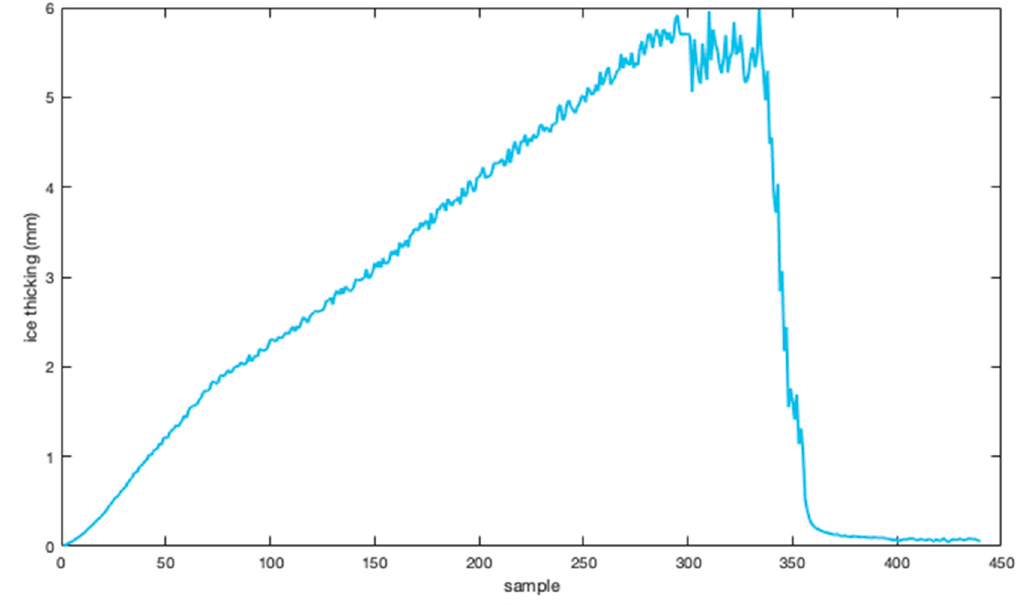
Figure 5. Icing thickness change trend of “Yangdong Line.”